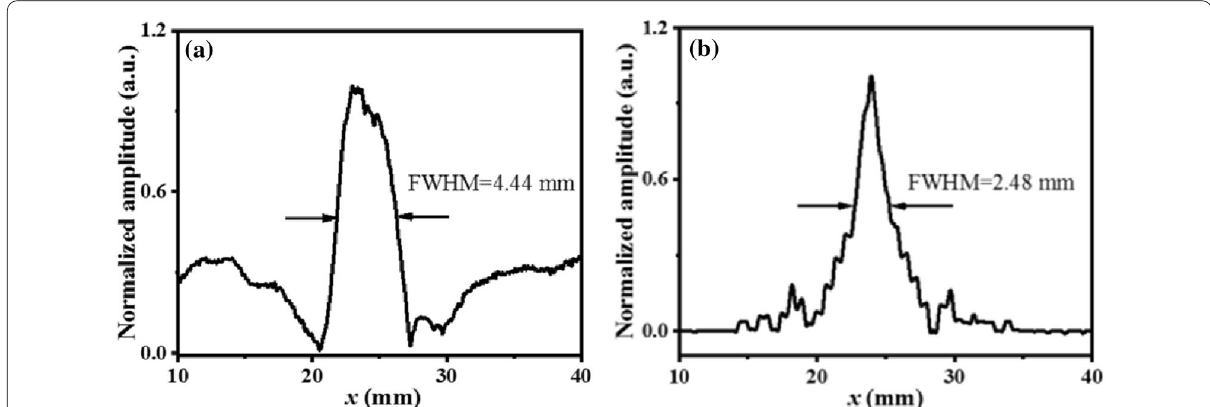
Figure 9 Transverse profile graphs corresponding to the lower tip of the artificial defect in different reconstructed images: ( a ) SAFT image, ( b ) Sparse-SAFT